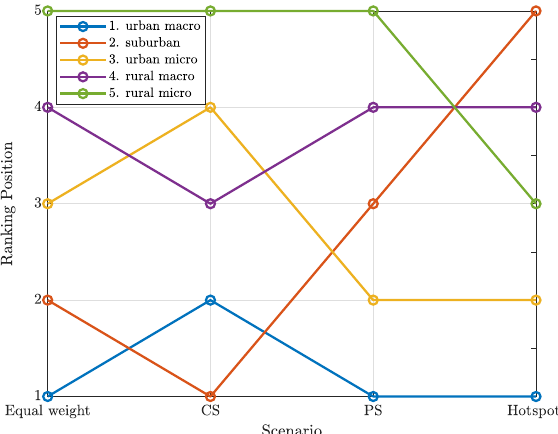
Figure 3. Cluster ranking according to